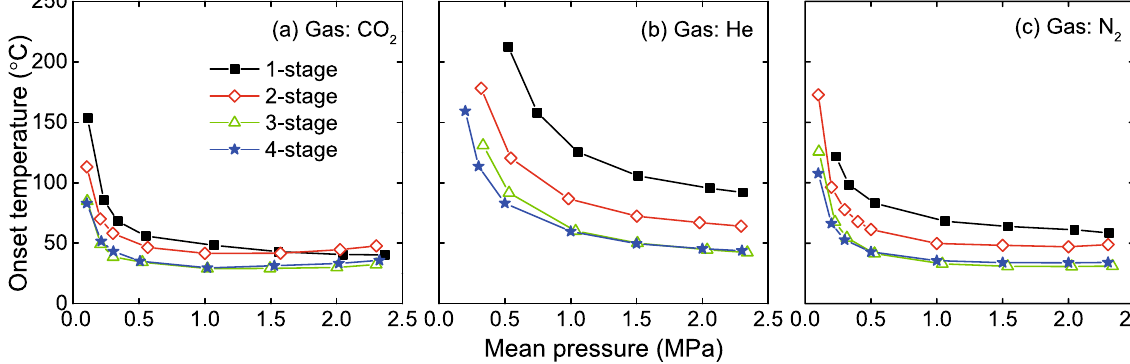
Figure 3. Onset temperatures under different mean pressures.